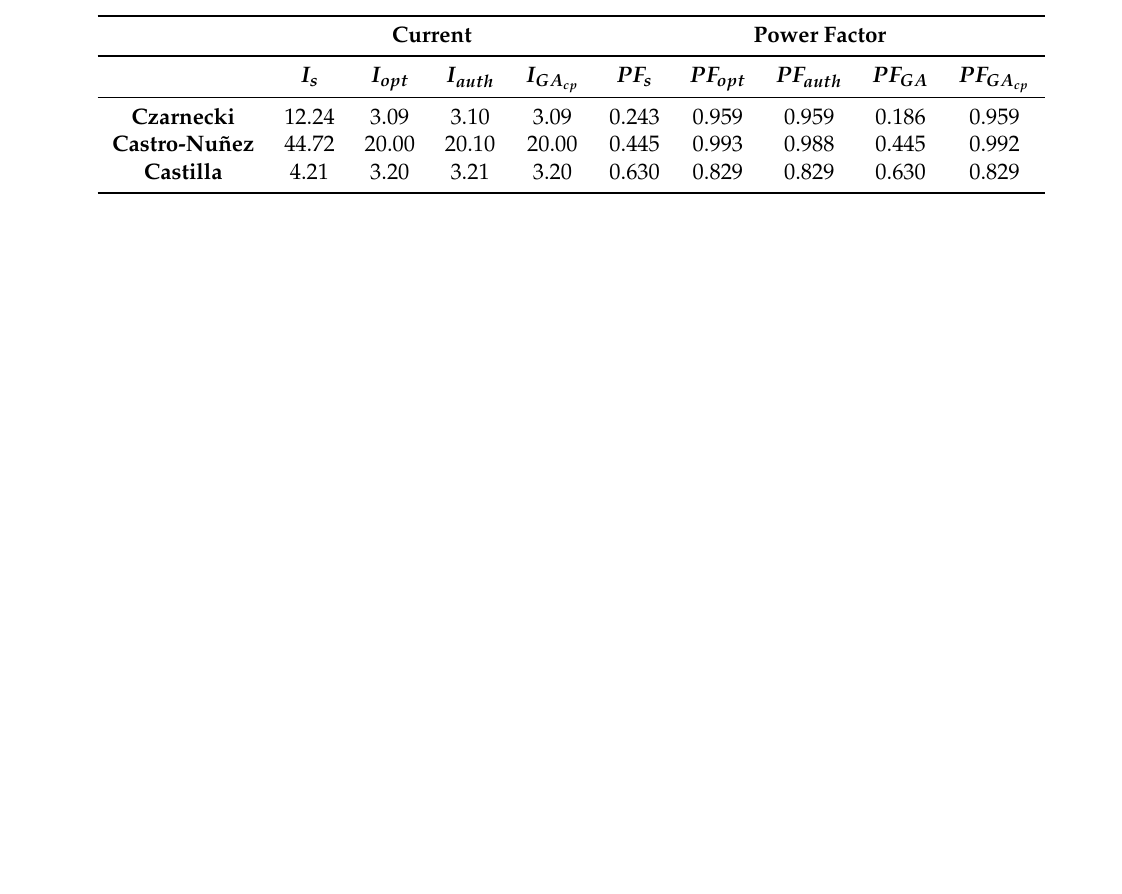
Table 5. Comparison table for currents and power